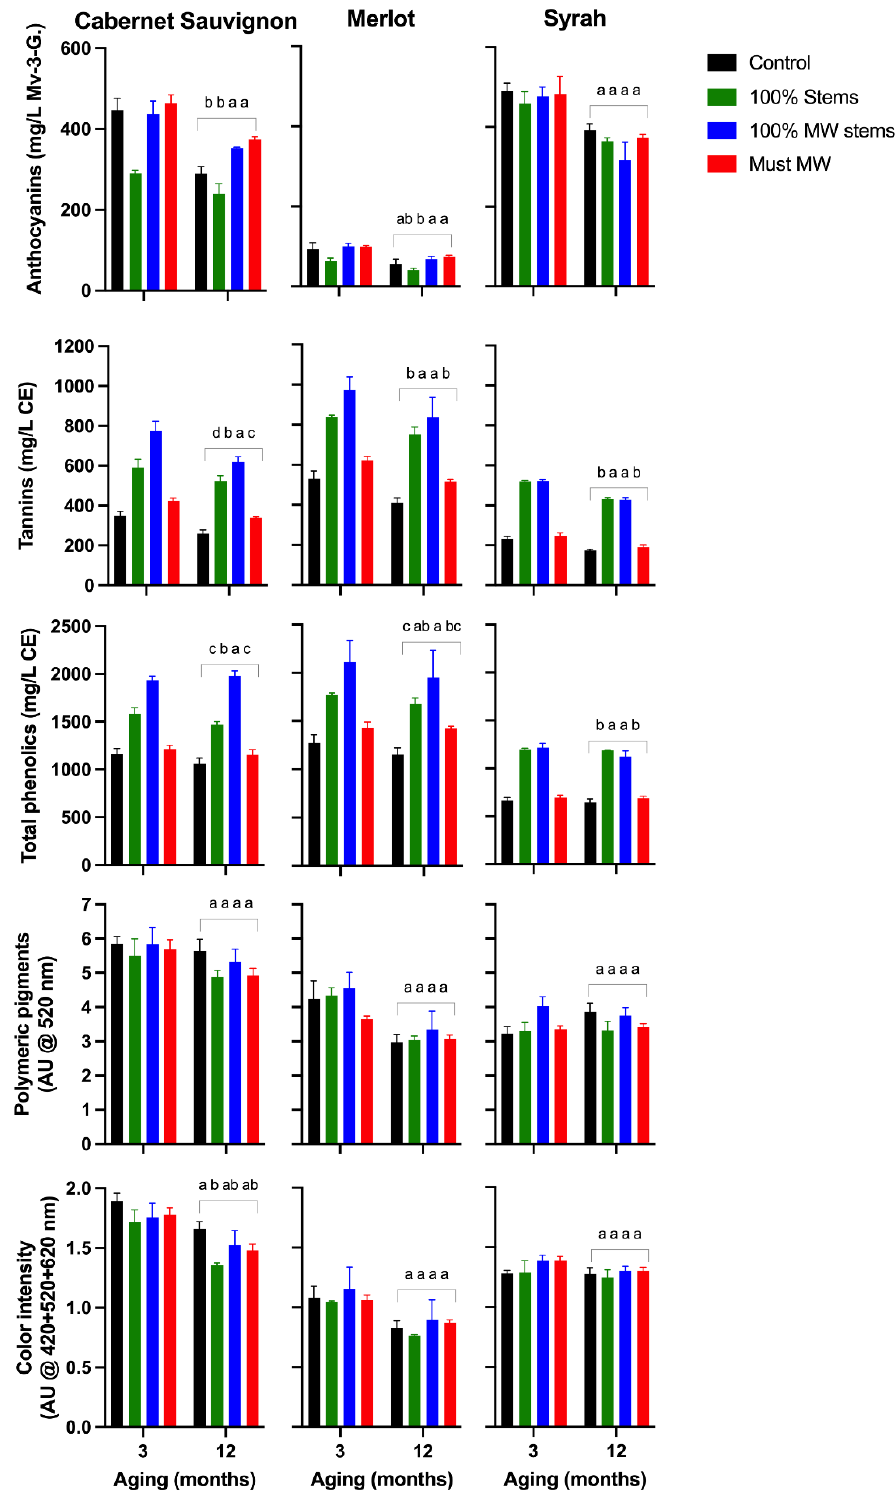
Figure 1. Evolution during bottle aging of selected phenolic classes and wine color in the wines of the 2016 vintage. Different letters in the last sampling point (12 months of bottle aging), indicate significant differences for Fisher’s LSD test and p < 0.05. Mv-3-G.: malvidin-3-glucoside equivalents; AU: absorbance units; CE: catechin-equivalents.